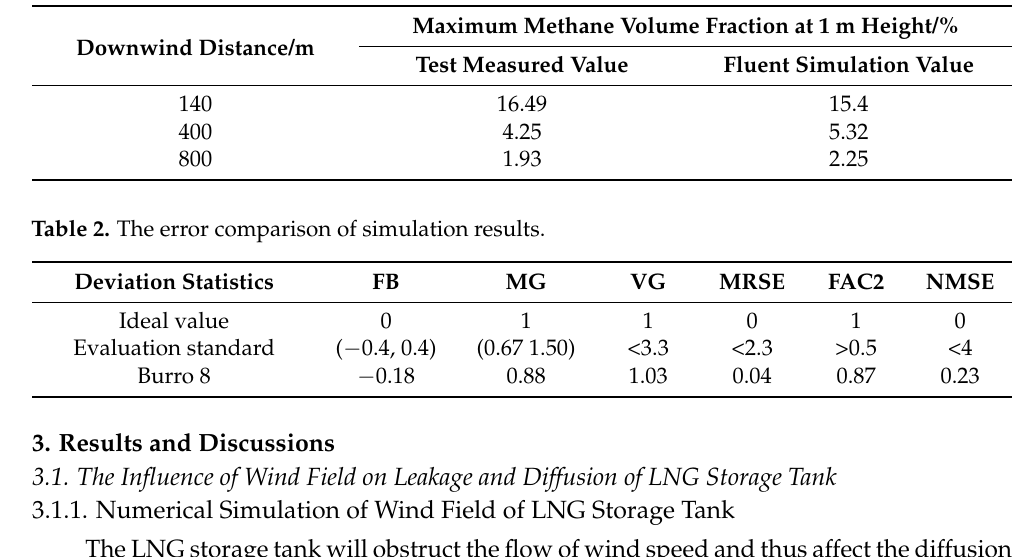
( b ) Vertical height y -1.5m Figure 6. The distribution of wind speed streamlines near the storage tank. 3.1.2. Leakage and Diffusion Process of LNG Storage Tank under Wind Field